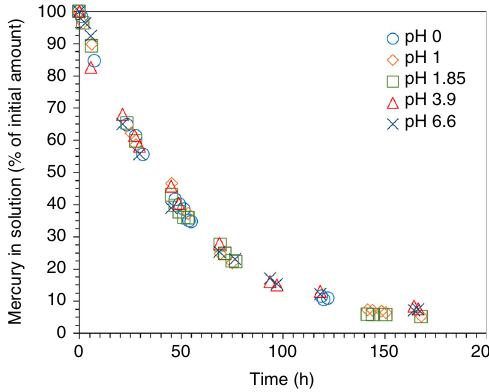
Fig. 3 In fl uence of pH on the decontamination process. The plot shows the decrease of mercury concentration from solutions containing 10 mg L − 1 mercury and various amounts of nitric acid: pH 0 (blue circles), pH 1 (orange diamonds), pH 1.85 (green squares), pH 3.9 (red triangles), and pH 6.6 (dark-blue crosses). [NO 3 − ] = 1 mol L − 1 . Working electrode: 100 nm platinum fi lm (2.25 cm 2 area). Counter electrode: platinum wire. Reference electrode: Hg/Hg 2 SO 4 . Potential = 0.16 V vs. RHE